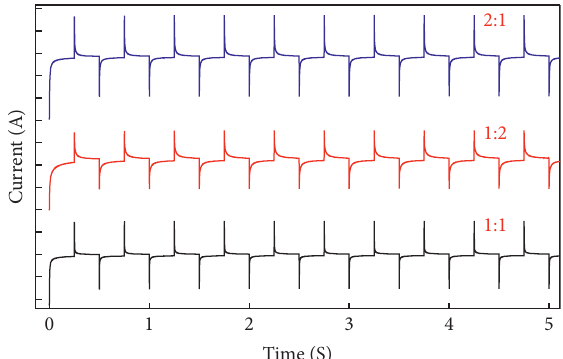
3 O 4 nanoelectrodes.